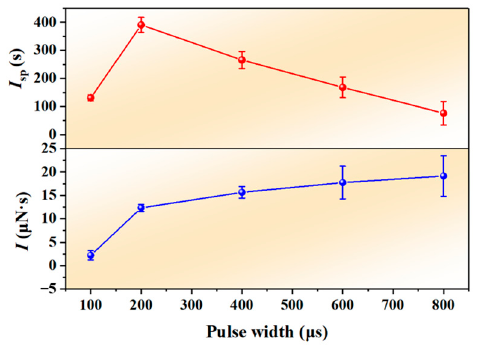
Figure 10. I and I sp as functions of laser pulse width.